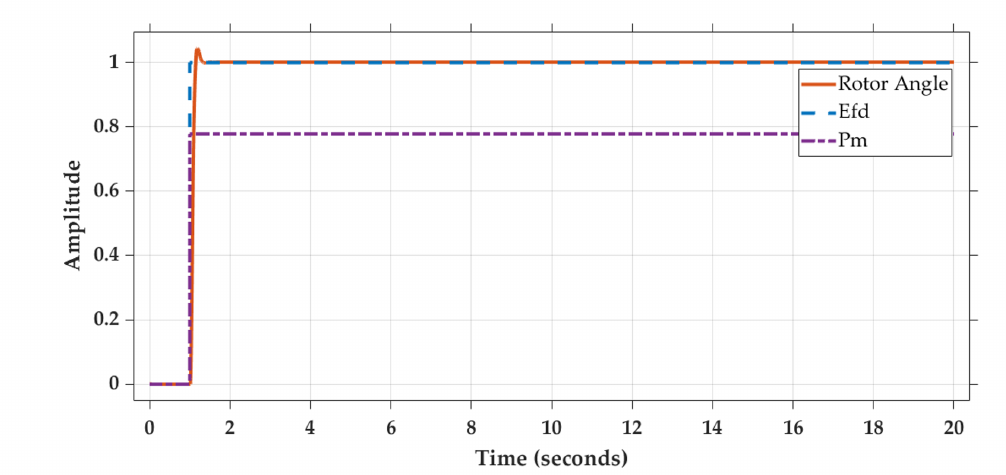
Figure 6. Rotor angle when E FD = 1, P m = 0.77778, and learning rate = 10. Case Study 4. Added disturbances at t = 0 s and no initial